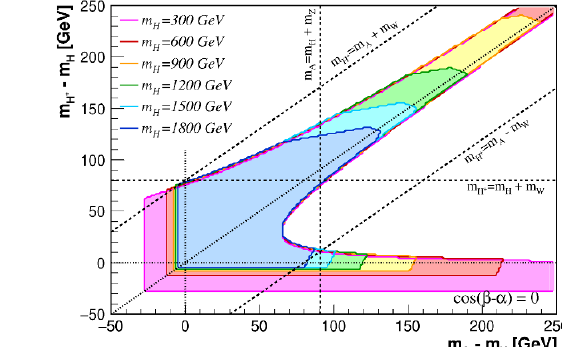
(left panel) and zoomed-in regions H (cid:6)